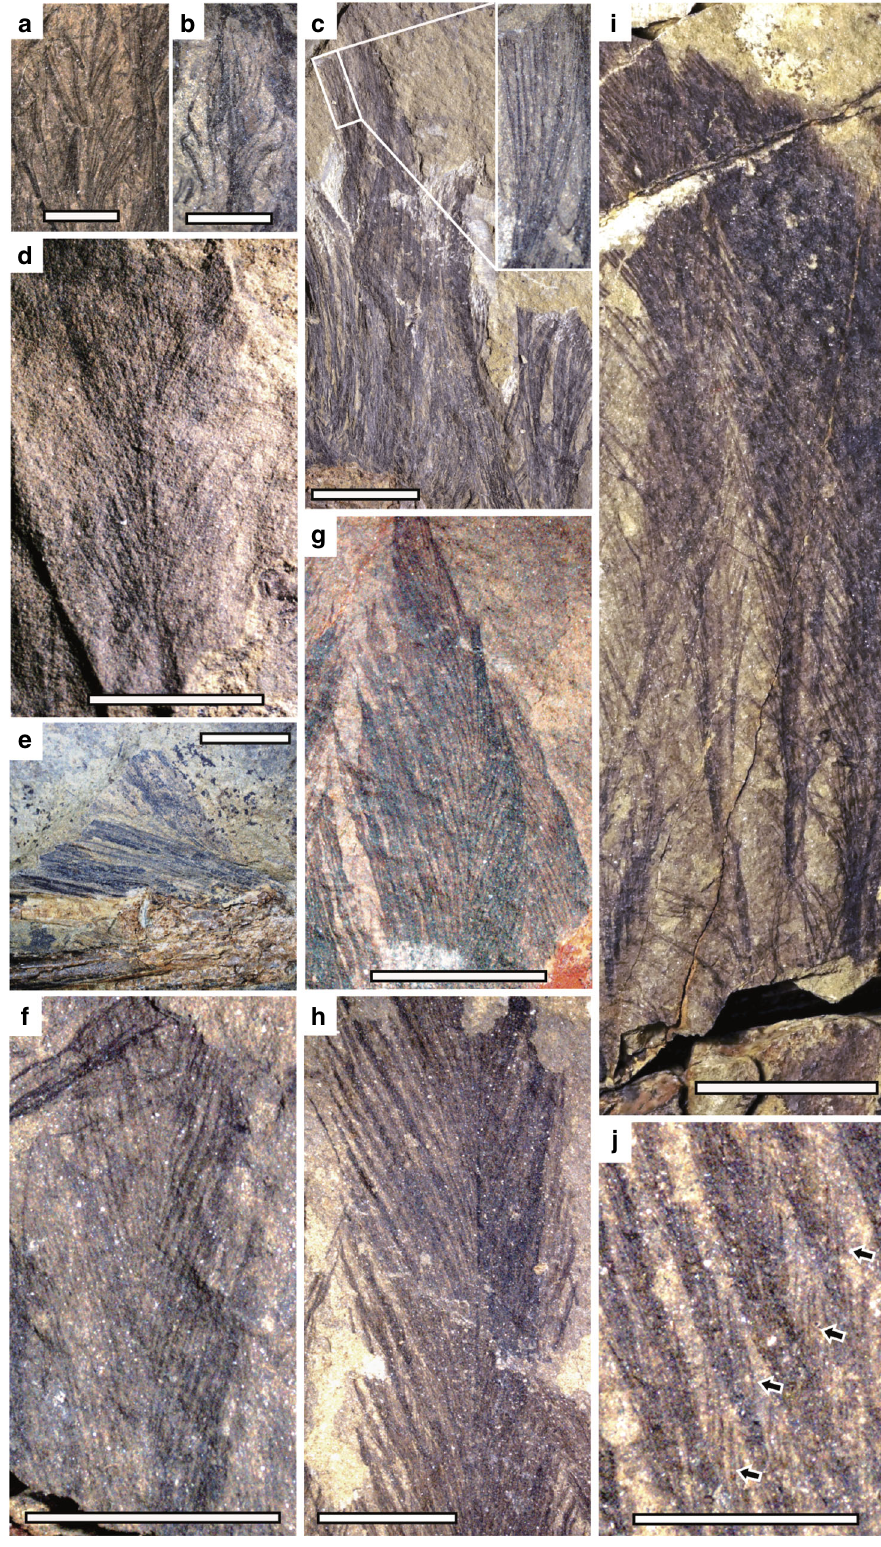
Fig. 4 Feathers preserved in Caihong juji . Feathers attached to the neck: ( a ) pennaceous feathers and ( b ) down-like feather; ( c ) feathers attached to the chest and trunk region; ( d ) primary or secondary remige near the carpal joint; ( e ) alula; ( f ) pennaceous feather on the tibiotarsus; ( g ) anterior rectrix; ( h ) posterior rectrix; ( i ) middle rectrix; ( j ) close-up of barbs and barbules. Scale bars are 0.2 cm in a , b , j ; 0.5 cm in d , e , f , g , h ; and 1 cm in c , i , respectively. Arrows in j indicate barbules of a